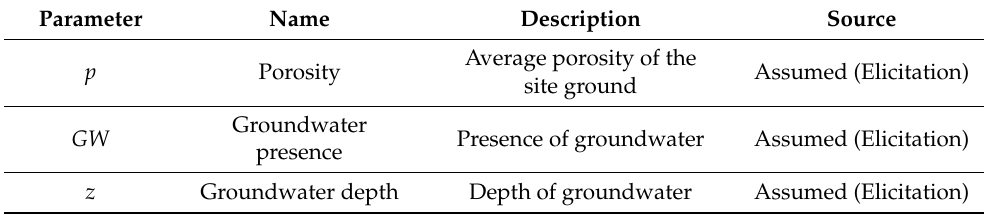
Table A2. Physical